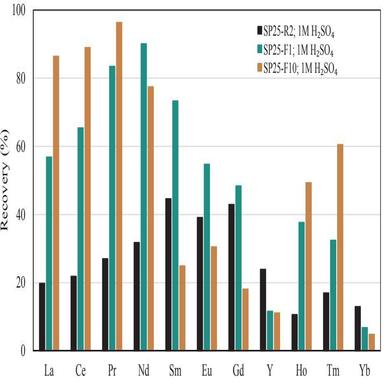
Final recoveries of individual REEs from the Guxu core samples using 1 M H2SO4 (Note: Tb, Dy, Er, and Lu are not included since their contents in the final leachates were lower than the detection limits of the ICP-OES used in this study).